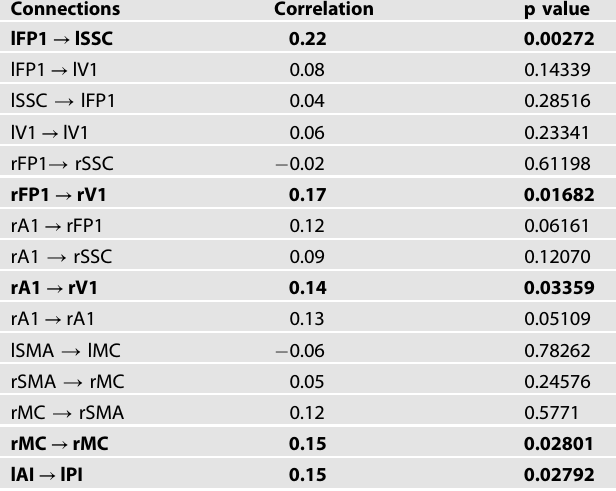
Table 1. Leave-one-out cross